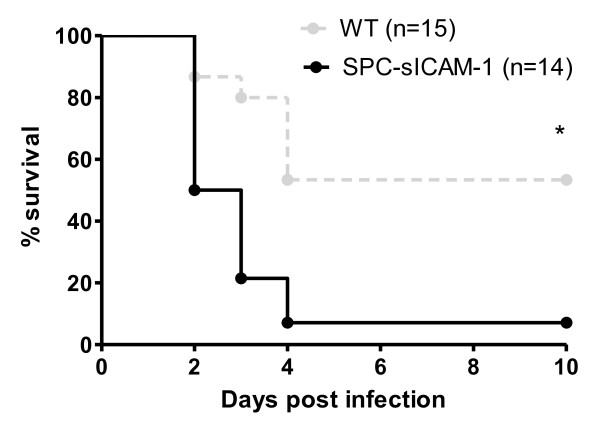
Overexpression of sICAM-1 in the distal lung results in decreased survival after K. pneumoniae infection. SPC-sICAM-1 mice and wild-type controls were inoculated intranasally with 2500 CFU of K. pneumoniae on day 0 and the percentage of mice surviving was determined over time. At 10 days, survival was significantly decreased in the SPC-sICAM-1 mice compared with infected wild-type controls. * P = 0.0012 compared with wild-type control mice.